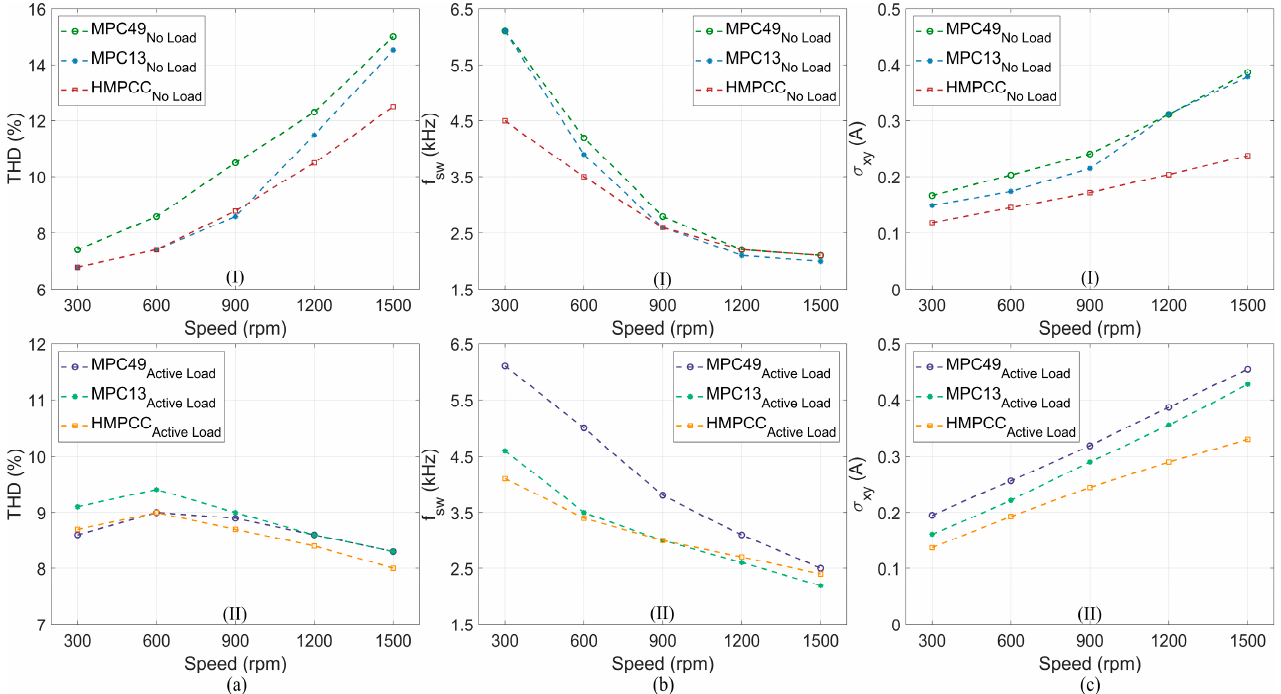
Figure 9. Test 2: THD (( a ) plots), switching frequency (( b ) plots)), and standard deviation of the x-y currents (( c ) plots)) for MPC49, MPC13, and the proposed method under no load and with active load.